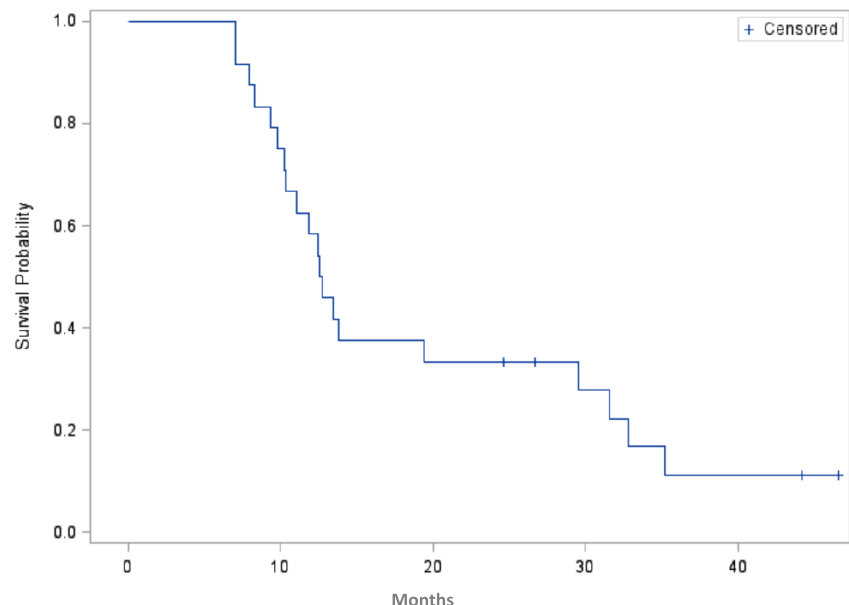
Figure 3. Progression-free survival in months for patients enrolled on the study ( n = 24, four patients are censored).